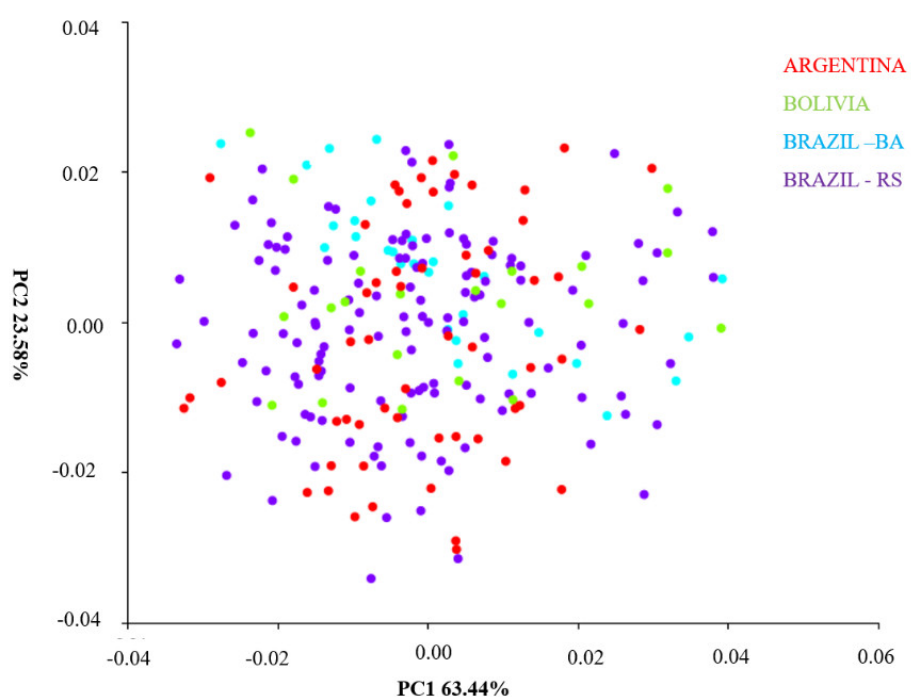
Figure 9. Principal component analysis (PCA) of T. infestans populations from different regions. TI24 (Guarani das Missões/RS/BR); TI25 (Argentina/Cordoba); TI26 (Argentina/Sta. Fe); TI27 (Entre Iju í s/RS/BR); TI28 (Sto. Cristo/RS/BR); TI131 (Sta. Rosa/RS/BR); TI156 (Sta. Rosa/residual foci/RS/BR); TI165 (Cochabamba/Bol í via); TI169 (Tremedal/residual foci/BA). BR-BRAZIL, RS-Rio Grande do